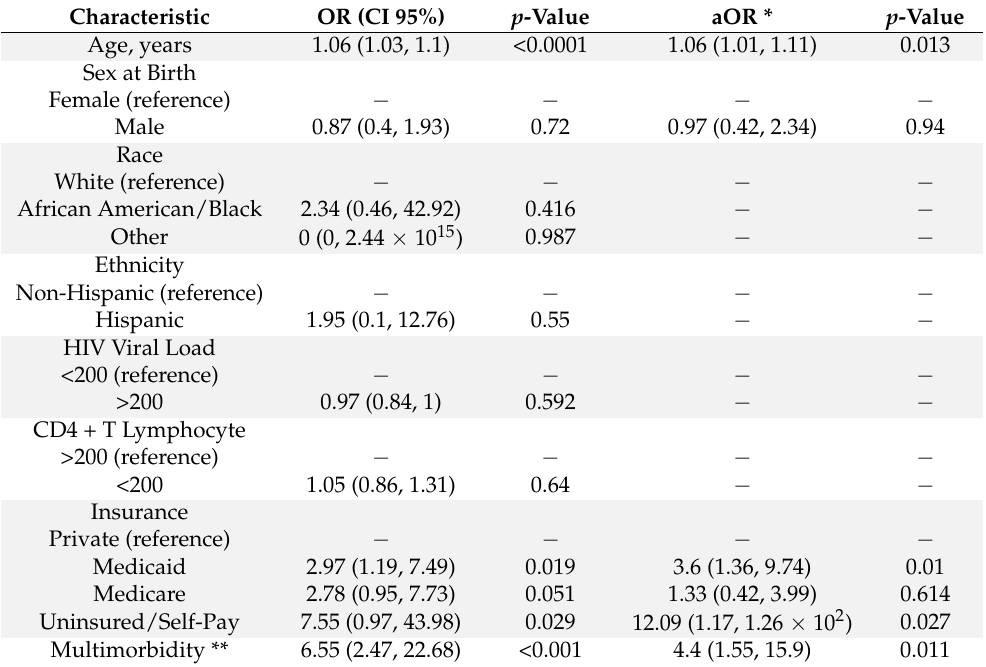
Table 3. Factors associated with death/mechanical ventilation among hospitalized PLWH with